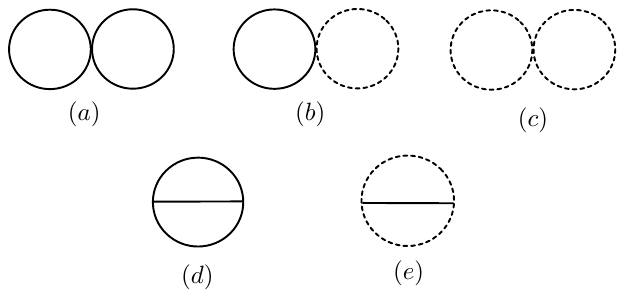
Figure 3 . Diagrams contributing to the two-loop e(cid:11)ective